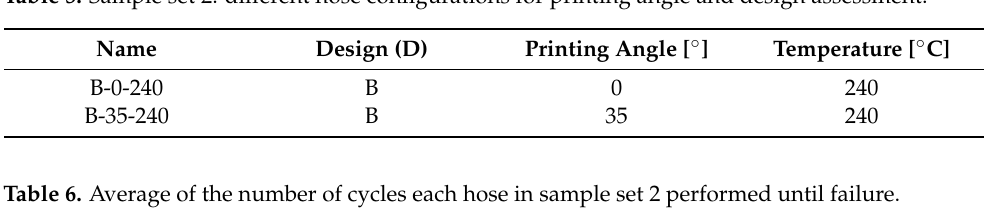
Table 5. Sample set 2: different hose configurations for printing angle and design assessment.